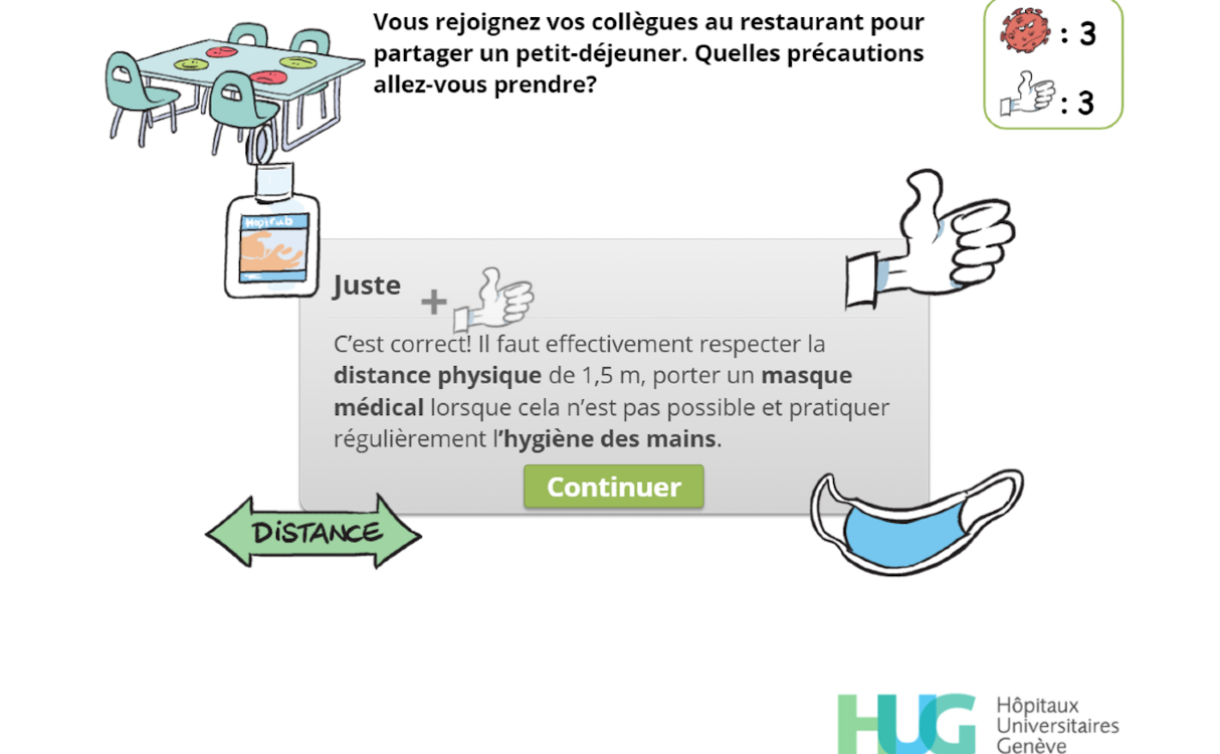
Figure 5. Feedback. The user has correctly answered the question. Visual hints related to the correct answers are displayed (mask, distance arrow, alcohol-based handrub) and a short text emphasizes the expected answers. A thumbs-up image and a plus sign appear, rise, and progressively fade out before the thumbs-up count is